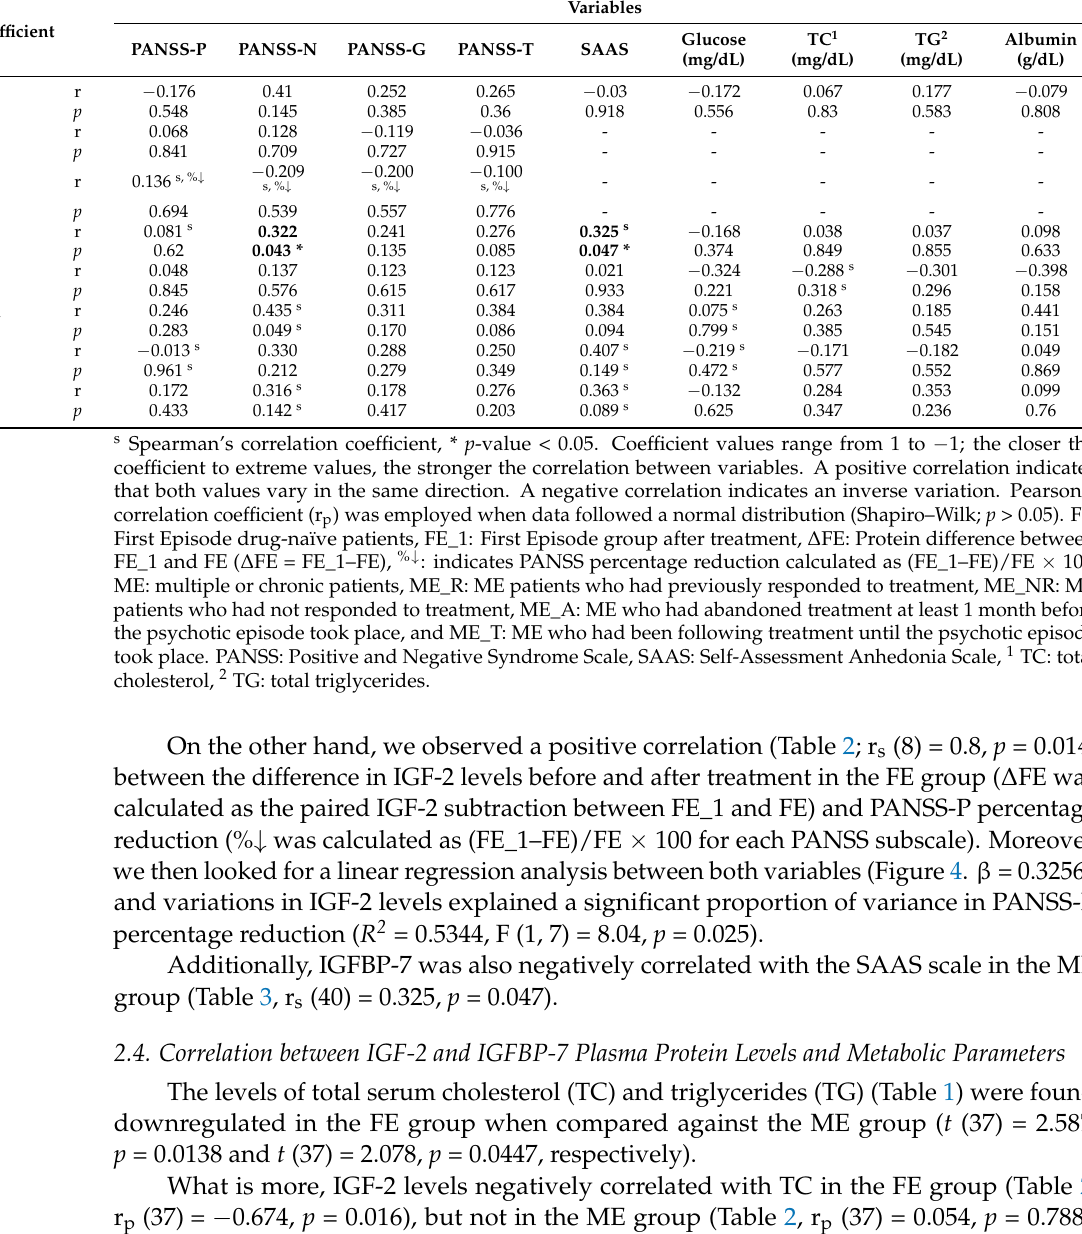
between glucose and albumin with IGF-2 (Table 2) or IGFBP-7 (Table 3) in all of the SZ groups